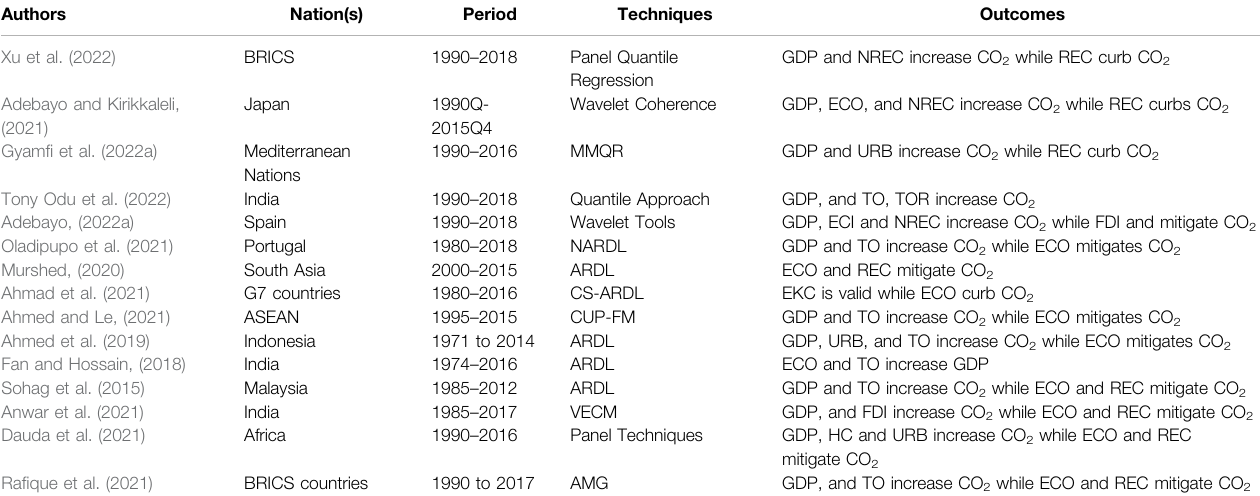
TABLE 1 | Synopsis of Related Studies.